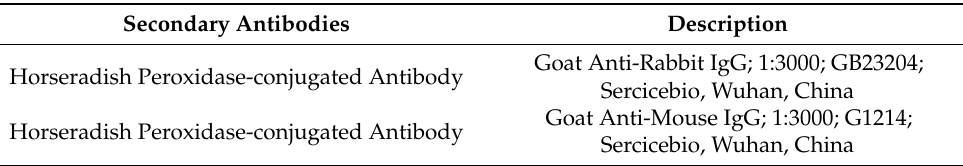
Table 3. Secondary antibodies used for Western blot experiments.